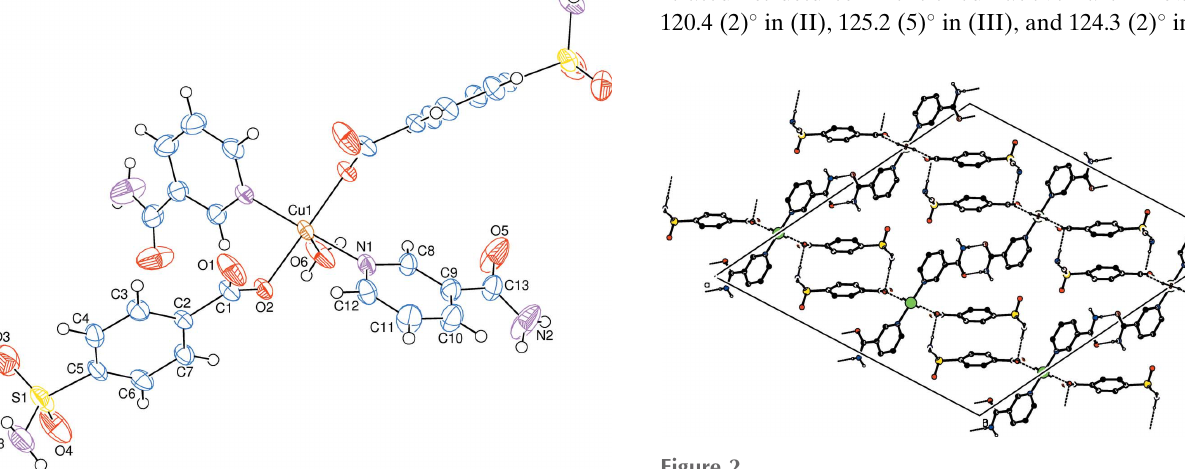
Figure 2 Part of the crystal structure, viewed down the b axis. O—H W (cid:2)(cid:2)(cid:2) O C , N— H NA (cid:2)(cid:2)(cid:2) O NA , N—H SB (cid:2)(cid:2)(cid:2) O C and N—H SB (cid:2)(cid:2)(cid:2) O SB (W = water, C = carboxylate, NA = nicotinamide and SB = 4-sulfamoylbenzoate) hydrogen bonds, enclosing R 2 (8) and R 2 (18) ring motifs, are shown as 2 2 dashed lines. H atoms not involved in these interactions have been omitted for